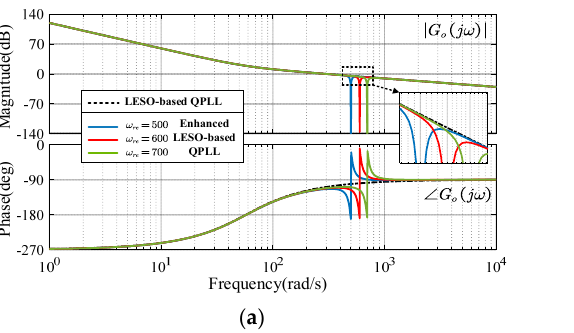
ω . ( b ) Bode diagram of re